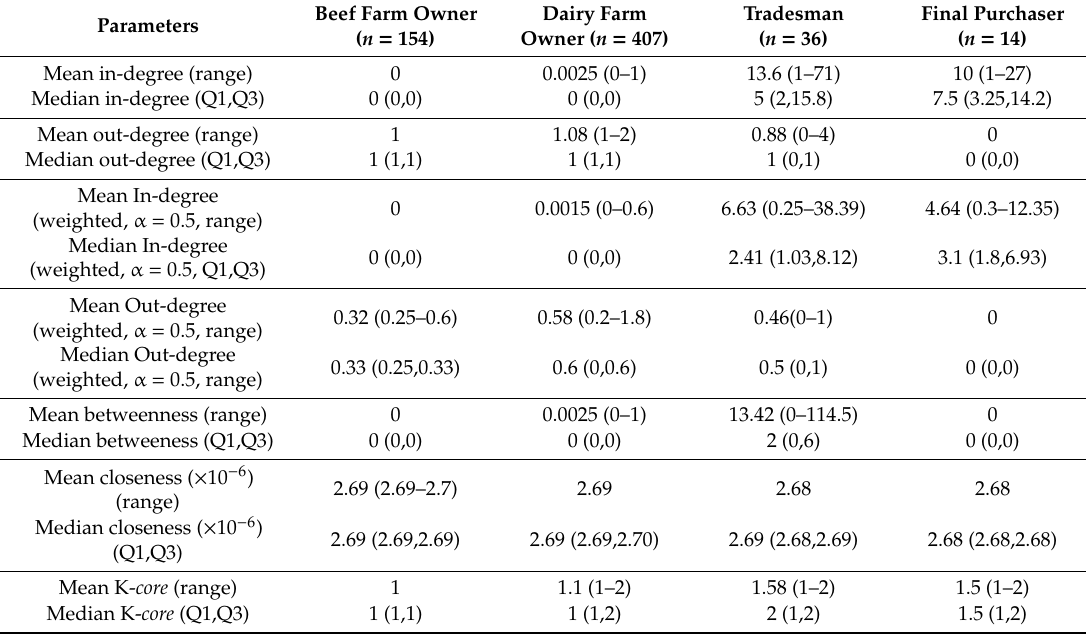
Table 4. Network parameters of the types of nodes in the manure trade network involved in this study. Parameters